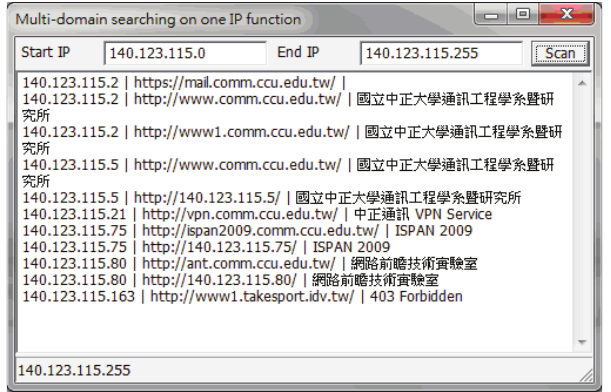
Figure 12: Multidomain searching on one IP function.